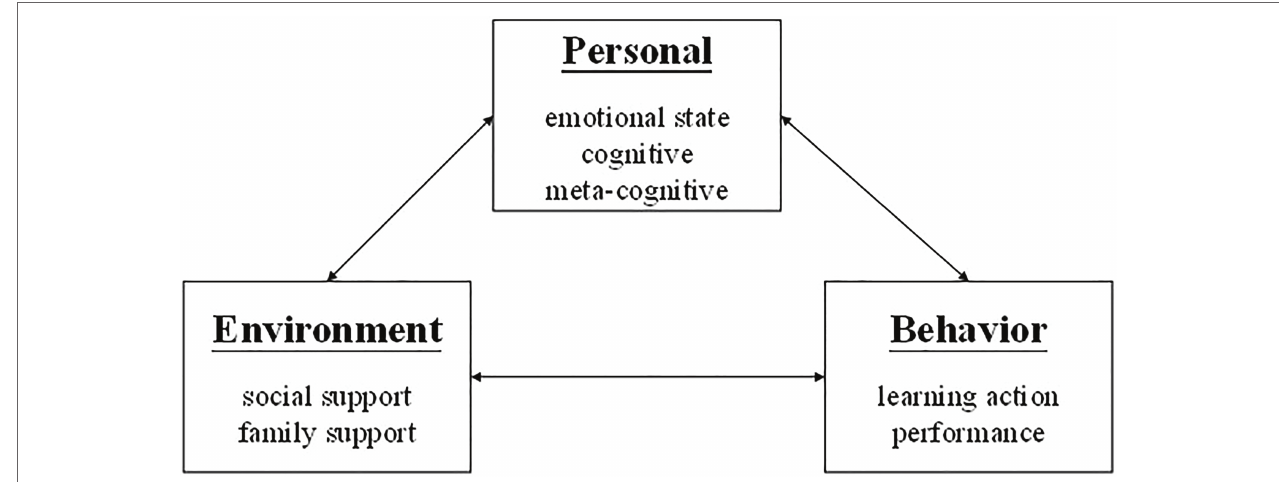
FIGURE 1 | Social cognitive